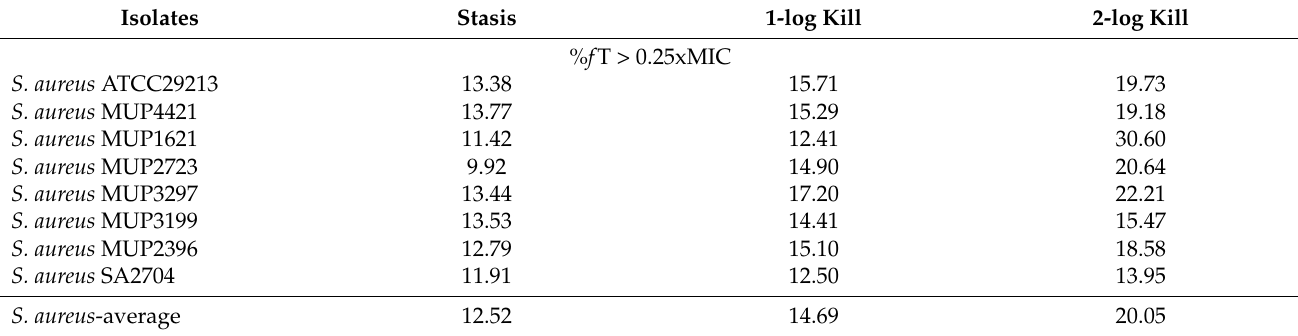
Figure 2. Dose–response of flucloxacillin against six S. aureus , one S. pyogenes and one S. agalactiae isolates in the neutropenic murine thigh infection model. Each symbol represents a therapy response in one mouse thigh. The x axis is the flucloxacillin exposure expressed as the percentage of time the unbound concentration was above 0.25 times the MIC (1 time the MIC for S. pyogenes ). The y axis is the change in log 10 of bacterial load from the start of treatment. The line is the best fit based on the sigmoid E max model. Table 2. Values for the PK/PD index for the individual isolates and the average, median, and SD for the eight S. aureus isolates, one S. agalactiae and one S. pyogenes